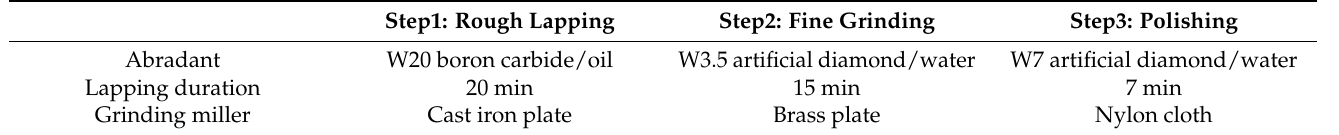
Table 2. Machining information of experiment sample surface of WC-Ni.